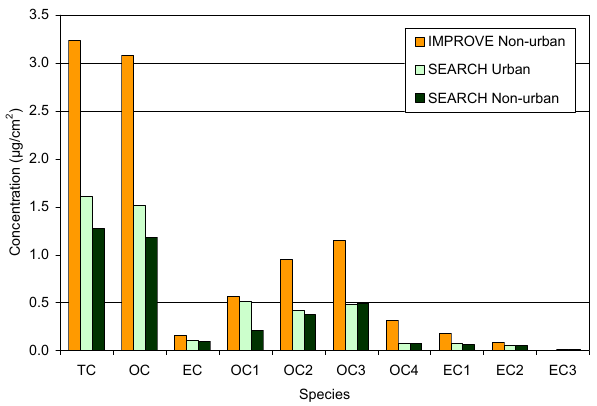
Pallflex® Tissuquartz while STN/CSN used QMA quartz- Fig 5. Fig. 5. Comparison of quartz-fiber backup filter (QBQ) carbon fractions between the urban and fiber filters prior to 2007, and these filters may differ Fig. 5. Comparison of quartz-fiber backup filter (QBQ) carbon non-urban sites in the IMPROVE and SEARCH networks for the period from 1 January 2005 in: 1) capacity and affinity for VOC and gaseous SVOC fractions between urban and non-urban sites in the IMPROVE to 31 December 2006. Carbon fractions follow the IMPROVE A thermal / optical reflectance (TOR) protocol (Chow et al., 2007). and SEARCH networks for the period from 1 January 2005 to adsorption and desorption, and 2) the rate to reach saturation 31 December 2006. Carbon fractions follow the IMPROVE A or equilibrium between gaseous SVOC and particulate OC. thermal/optical reflectance (TOR) protocol (Chow et al., 2007). The effects of these differences cannot be determined from available 27397 are similar, with a few bQF levels higher than those of tbQF.